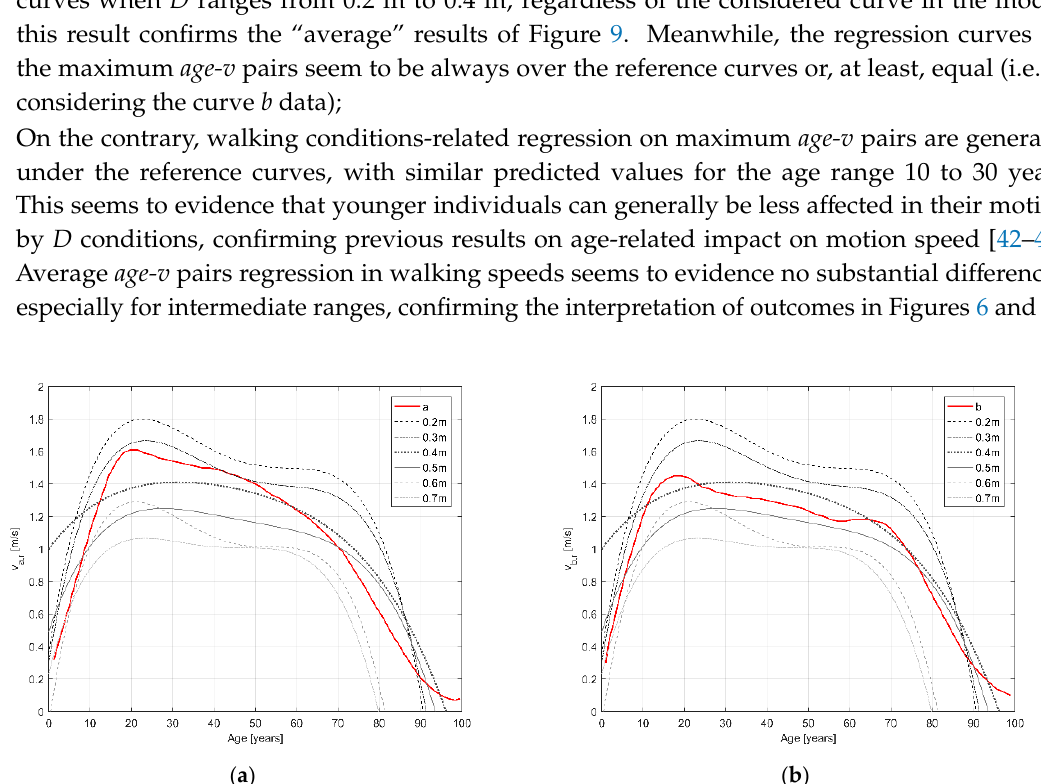
Figure 11. Average dimensional age-evacuation speed (m/s) model in running conditions, for the different D values according to a polynomial (4th degree) regression model, performed on all the experimental pairs (male and female together): ( a ) compared to the curve a [46]; ( b ) compared to the curve b [43].